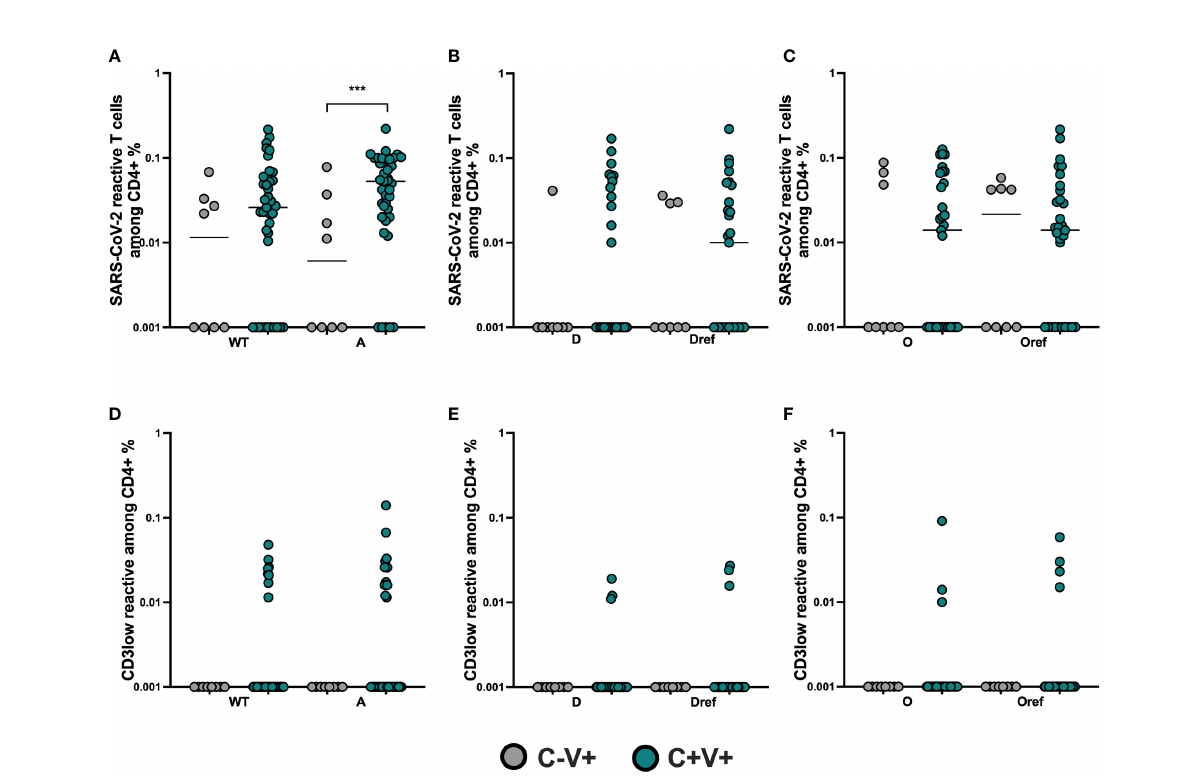
FIGURE 2 Comparable magnitude of SARS-CoV-2 CD4+ T cell response in C+V+ and C-V+. Comparison of SARS-CoV-2 S-reactive T cells among C+V+ and C-V+ study subjects. (A) Frequencies of WT- and alpha (A) -reactive CD4+ T cells. (B) Frequencies of delta (D)- and delta reference pool (Dref)-reactive CD4+ T cells. (C) Frequencies of omicron (O)- and omicon reference pool (Oref)-reactive CD4+ T cells. (D) Avidity of SARS-CoV- 2 reactive CD4+ T cells was approached by determining the CD3low+ cells among CD4+CD154+CD137+ cells. Frequencies of WT- and alpha- reactive CD4+CD3low+ T cells. (E) Frequencies of delta- and Dref-reactive CD4+CD3low+ T cells. (F) Frequencies of omicron- and Oref- reactive CD4+CD3low+ T cells. Antigen-reactive responses were considered positive after the non-reactive background was subtracted, and more than 0.01% were detectable. Scatterplots show line at median. Unpaired data were compared with Mann-Whitney-test. P<0.05 was considered signi fi cant, only signi fi cant p values are documented in the fi gures.